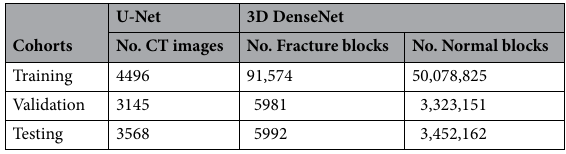
Table 2. The overview of dataset for the training of U-Net and 3D